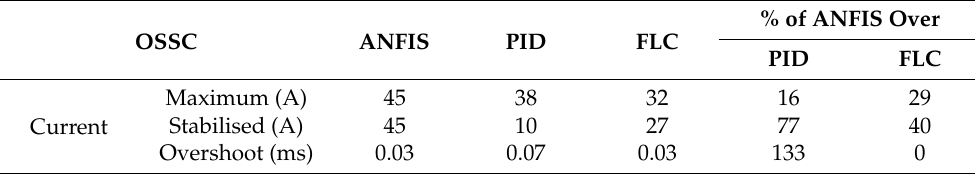
Table 10. ANFIS best for OSSC PMS at irradiance = 1000 W/m 2 .